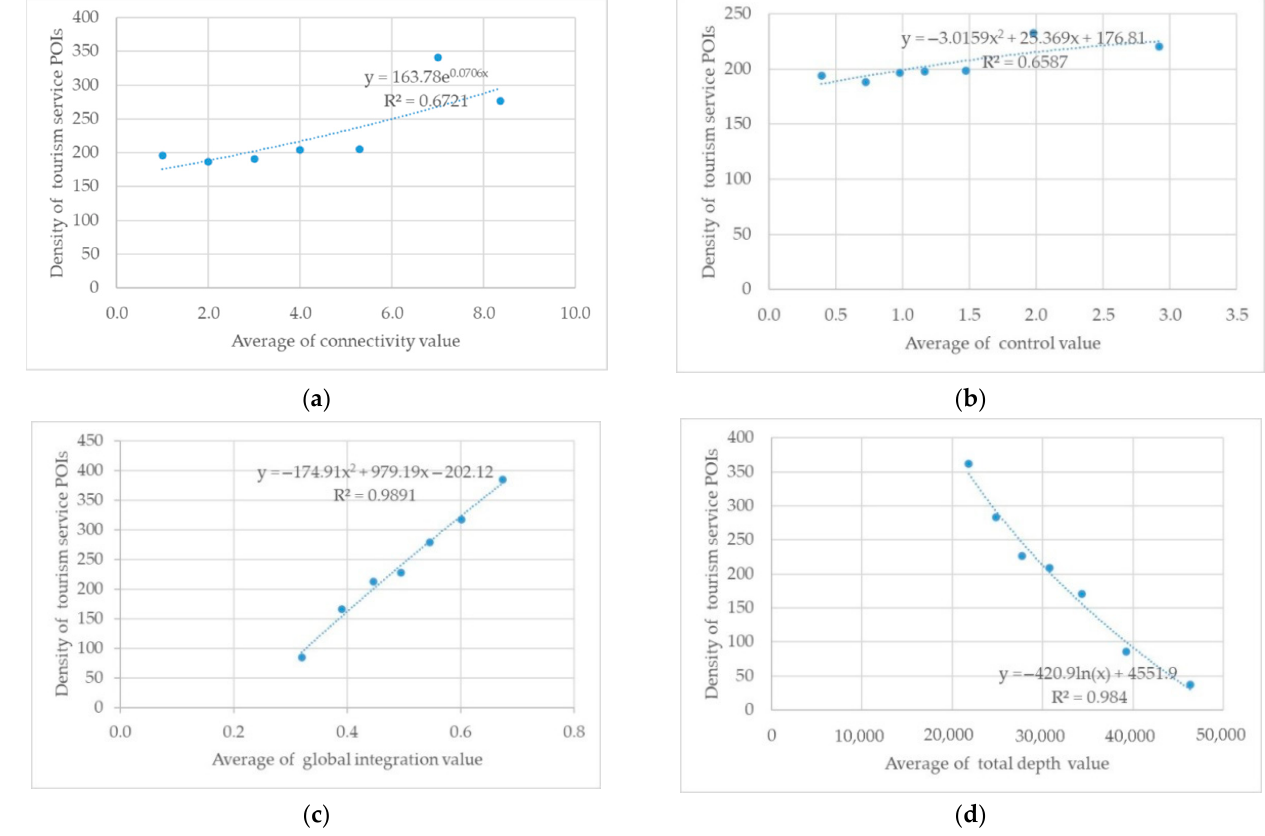
Figure 6. Scatter plot of average of each spatial variables and density of tourism service POIs: ( a ) connectivity value; ( b ) control value; ( c ) global integration value; ( d ) total depth value.